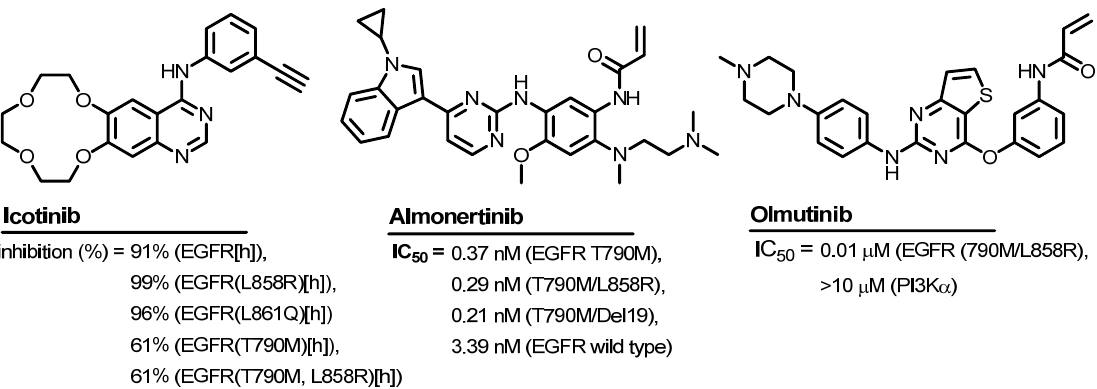
Figure 1. Icotinib, almonertinib, and olmutinib with their inhibition%/IC 50 values against EGFR. Olmutinib (Figure 1) was also approved for the treatment of advanced EGFR T790M mutation-positive NSCLC in South Korea [20]. It acts as an irreversible inhibitor of